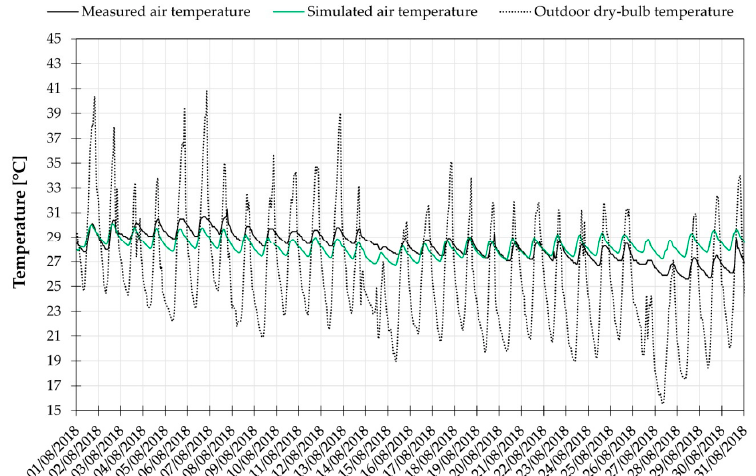
Figure 9. Building envelope performance validation based on measured air temperature in the selected office room during the month of August.